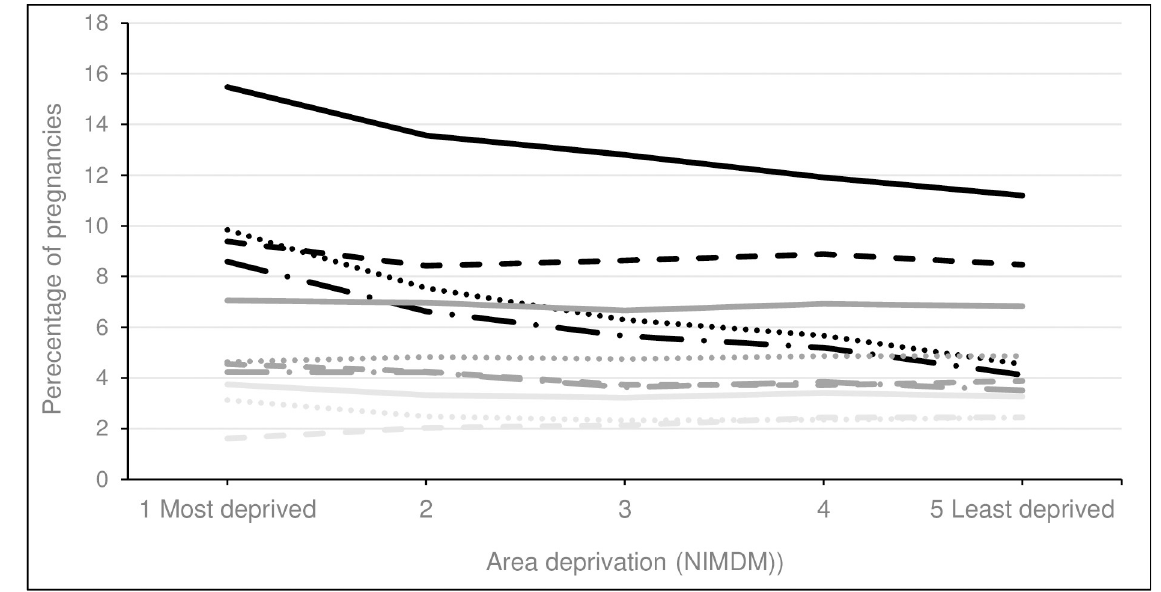
Fig 6. Percentage of pregnancies exposed to most common therapeutic classes of medication across area of deprivation (NIMDM). a Increasing trend p < 0.001. Solid black line = antibiotics; Dotted black line = analgesics; Dashed black line = antiemetics; Long dashed black line = antidepressants; Solid grey line = hormonal medications; Dotted gey line = steroids; Dashed grey line = antiasthmatics; Long dashed grey line = laxatives; Solid light grey line = cardiovascular medications; Dotted light grey line = antihistamines; Dashed light grey line = thyroxine a